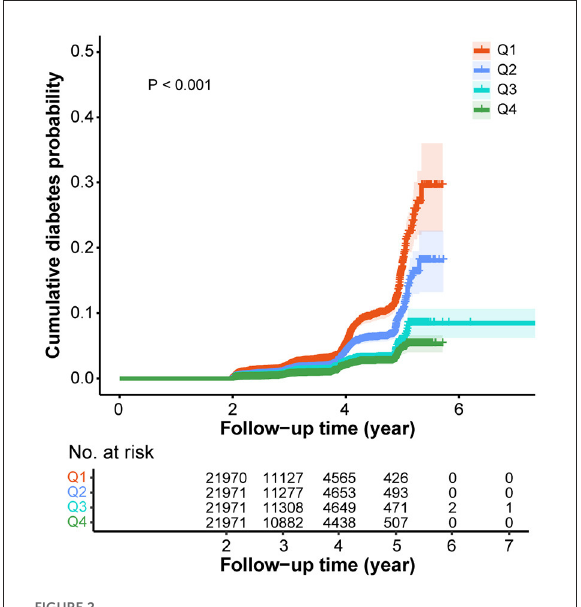
FIGURE2 Kaplan-Meier curves for the cumulative diabetes probability according to different ASL/ALT (DeRitis) ratio. Q1, < 0.89; Q2, 0.89-1.18; Q3, 1.18-1.53; Q4, > 1.53. ALT, alanine aminotransferase; AST, aspartate transaminase.